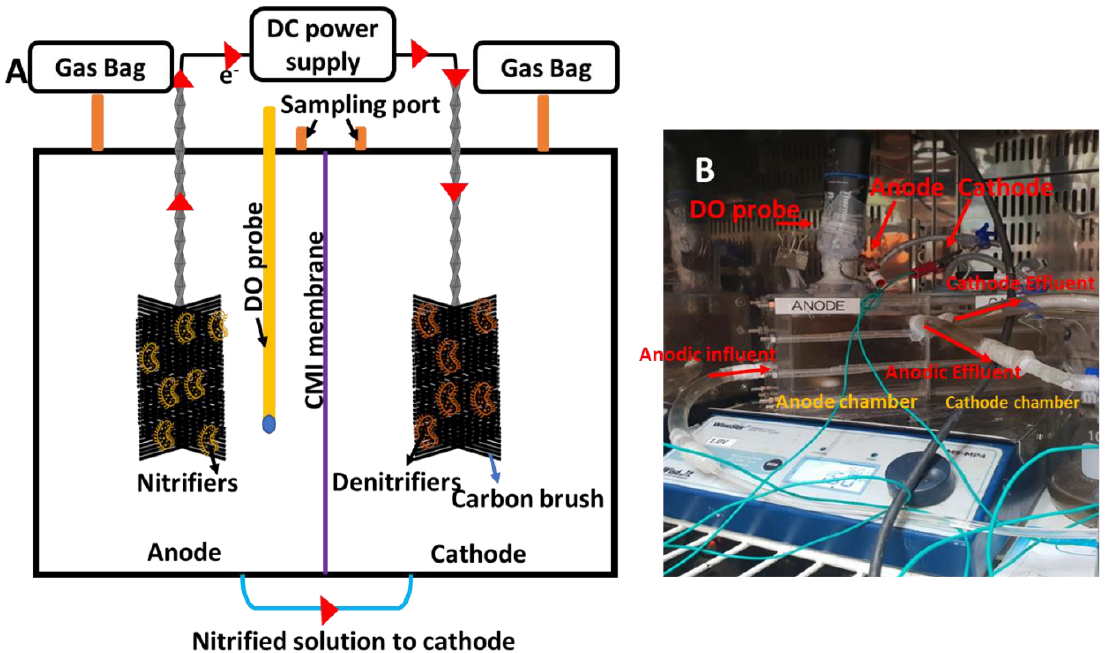
Figure 1. The schematic view ( A ) and photograph ( B ) of double chamber microbial electrolysis cell (MEC) used in this study for pursuing simultaneous nitrification and denitrification (SND) to remove nitrogen.